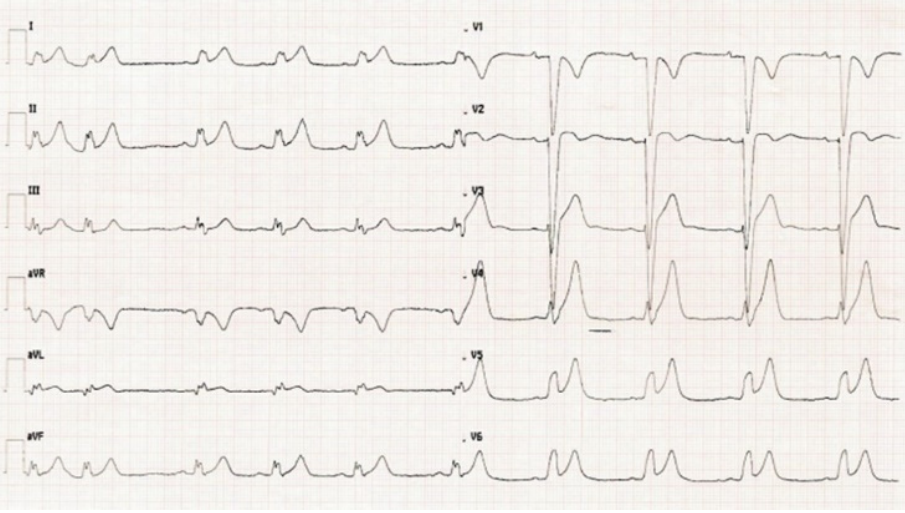
Figure 4. EKG during second chest pain episode.